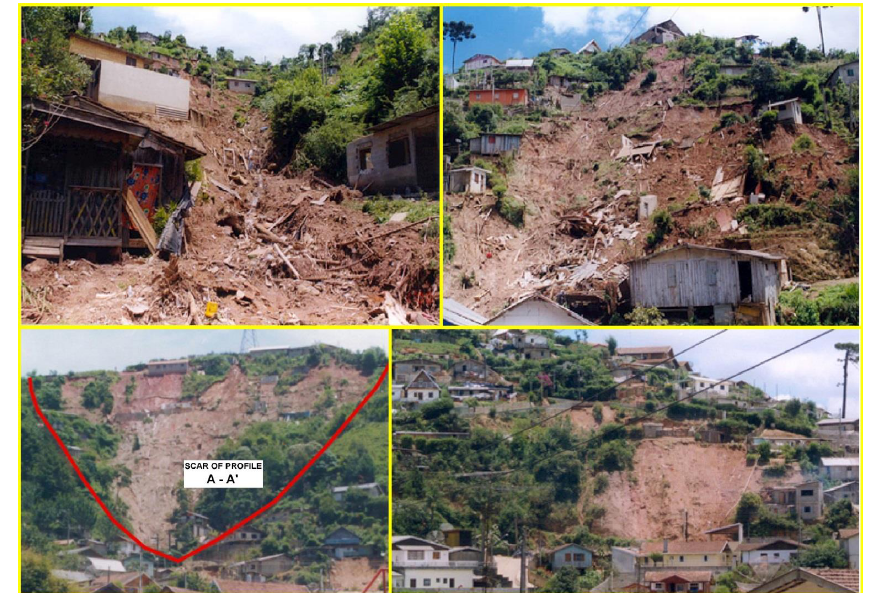
Figure 2. Shallow landslides that happened in 2000 at the study site (Source: Ridente et al.,